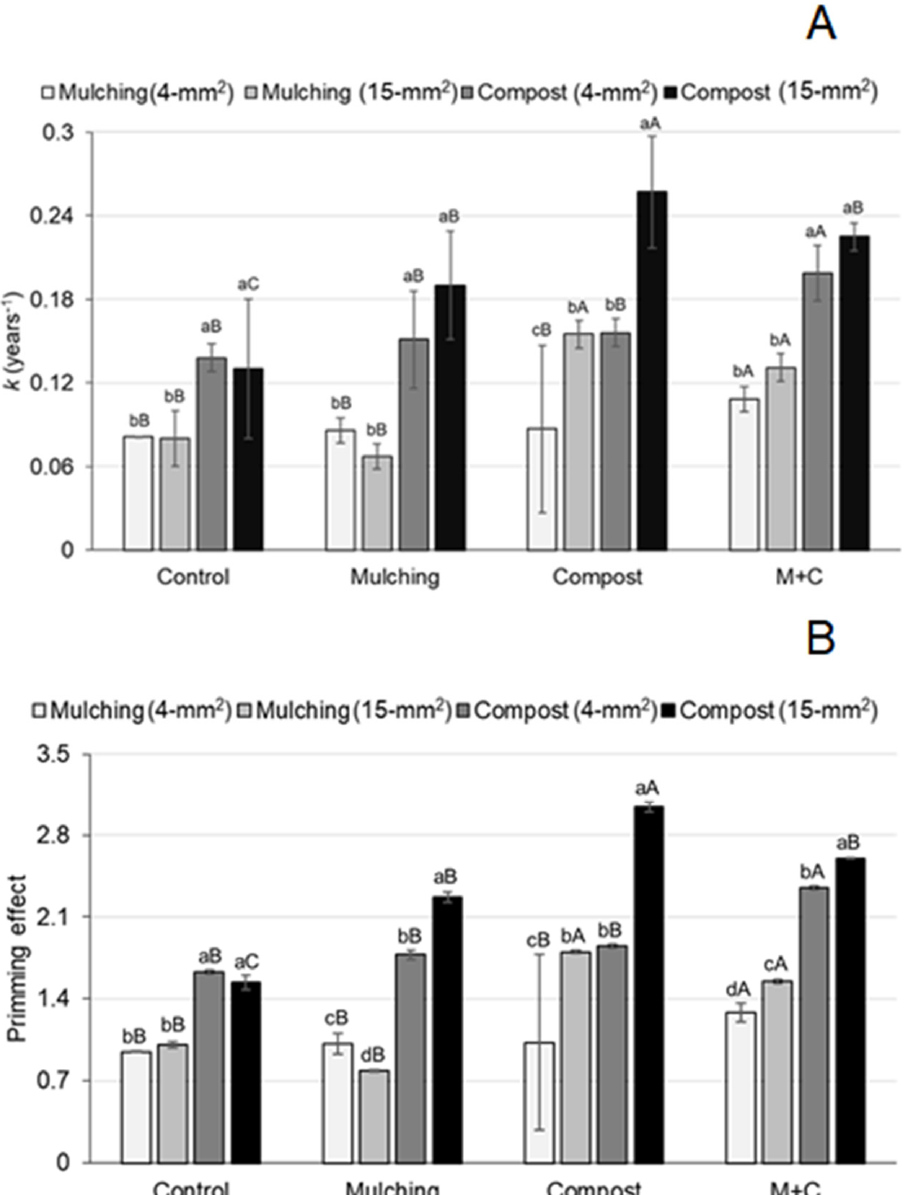
Figure 3. Decomposition rate (k, years − 1 , A ), and primming effect ( B ) as affected by different organic residues management and litterbag mesh-type in a subtropical ecosystem, Curitibanos, SC, Southern Brazil. Different small letters in each organic residue management differ by Bonferroni’s test ( p < 0.05), while different capital letters in each litterbag mesh-type differ by Bonferroni’s test ( p < 0.05). The decomposition rate was adjusted by multiplication by 10.